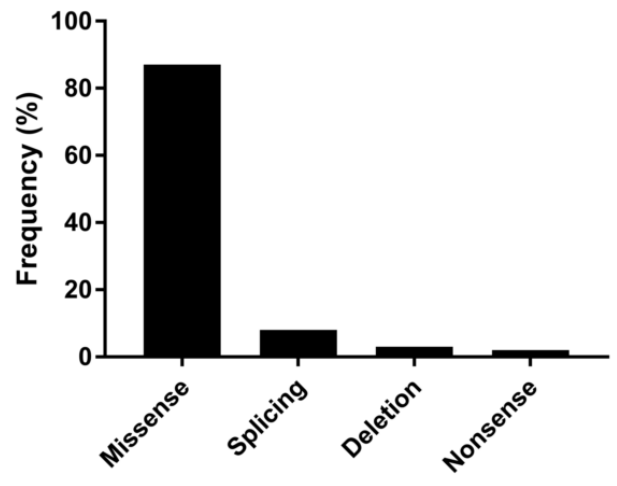
Figure 3. Different mutation types and their relative frequency among the pathogenic ones identified in this study.